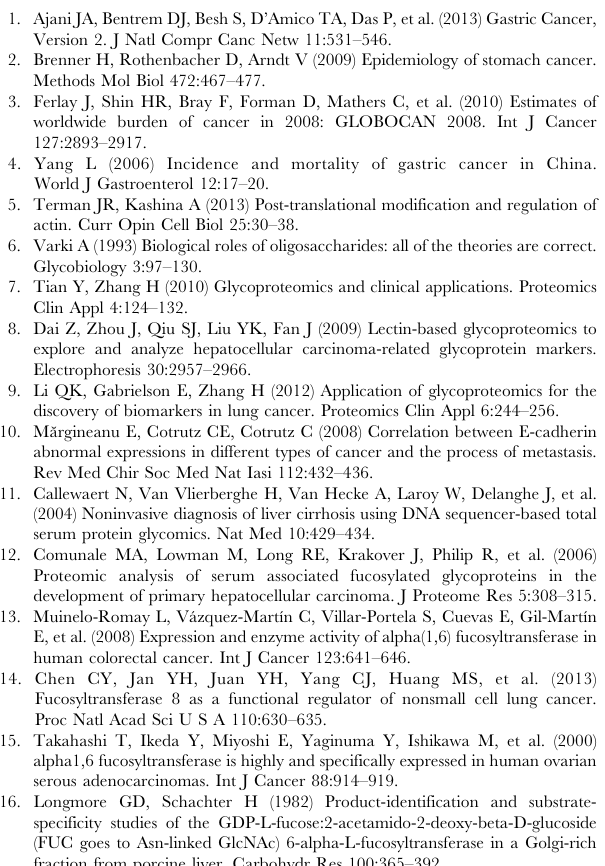
Figure S1 Raw figures of Fut8 Western blotting in tumor and adjacent tissue. Western blot analysis showed that the Fut8 in adjacent tissues was significantly higher than that in tumor tissues. T indicates tumor tissue, N indicates adjacent tissue, M indicates protein marker. NC indicates Purified albumin as negative control. Raw figures of Fut8 Western blotting (A) from 1th to 4th matched pairs, (B) from 5th to 7th matched pairs, (C) from 8th to 9th matched pairs.